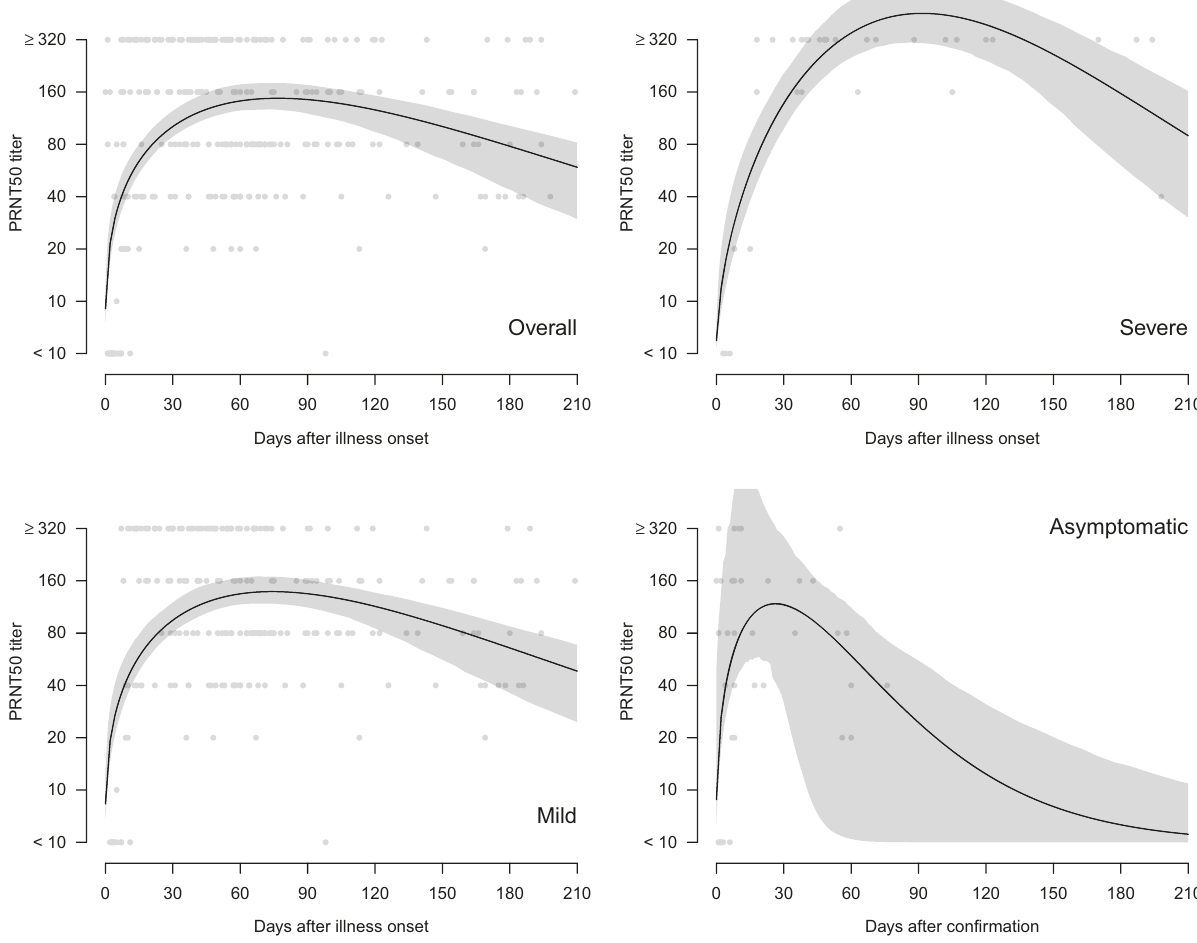
Fig. 2 Antibody responses (PRNT 50 ) in COVID-19 patients by days after illness onset and severity, Hong Kong ( n = 293 samples). The black lines showed the fi tted values and gray areas showed the 95% con fi dence intervals. Neutralization tests were carried out in duplicate.